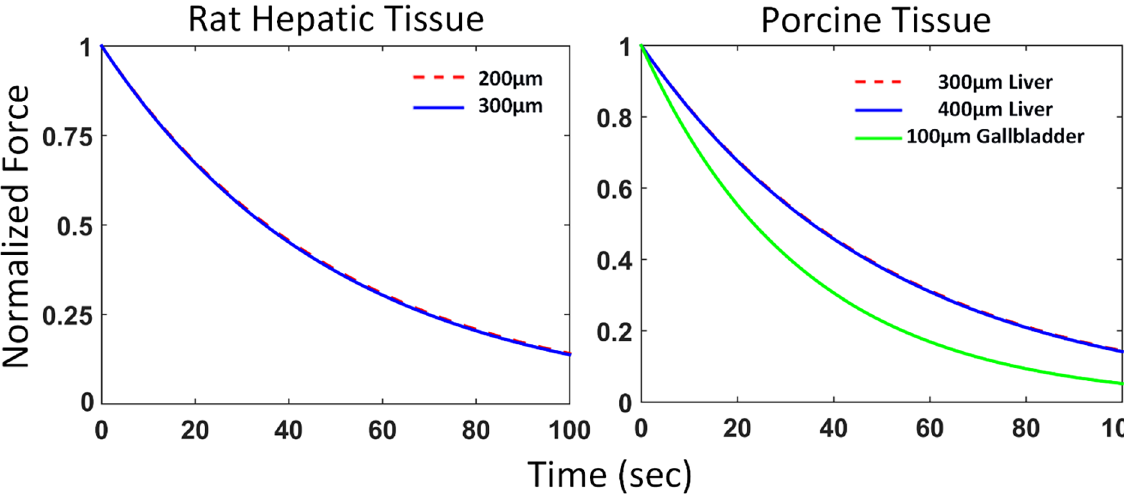
Fig 5. Mean elastic relaxation behavior plots of ex vivo animal tissues. The liver tissues for both rat and porcine models decay exponentially in a similar fashion for both indentation depths. The relaxation behaviors of the porcine gallbladder and liver tissue are very distinct, illustrating their unique viscoelastic